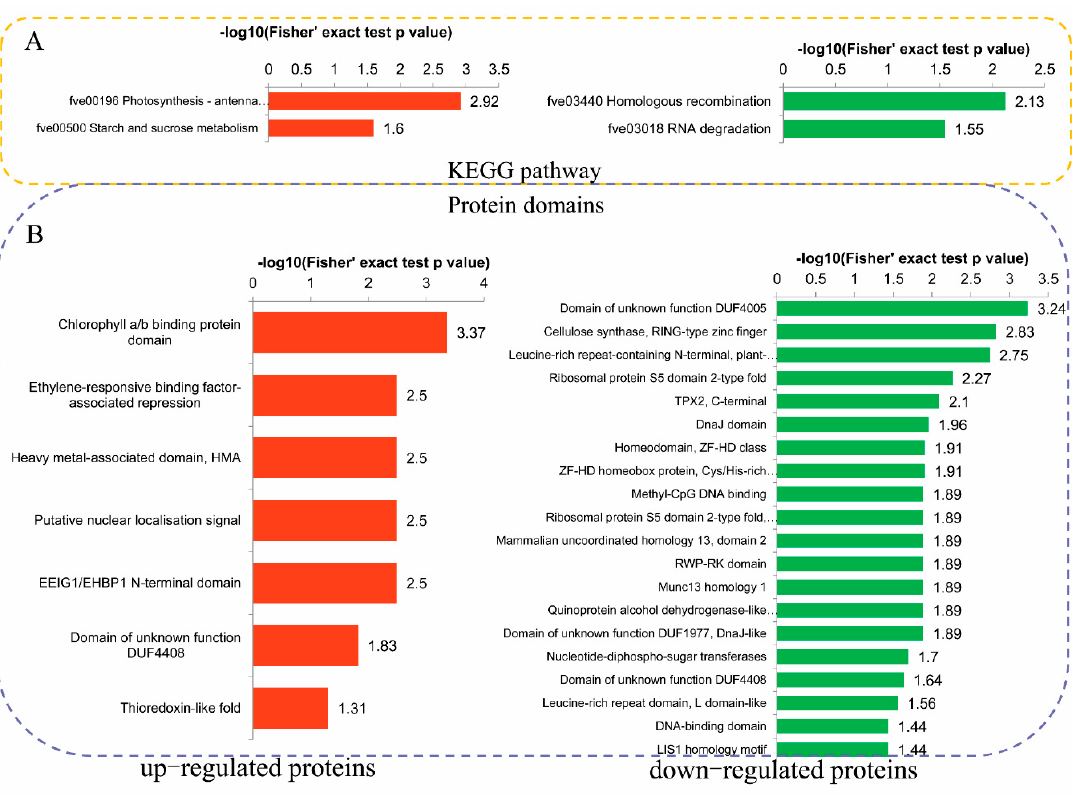
Figure 5. Kyoto Encyclopedia of Genes and Genomes (KEGG) and domain enrichment analysis of the DPPs in okra after salt stress treatment. ( A ) Significantly enriched KEGG pathways of the DPPs. ( B ) Significantly enriched protein domains of the DPPs.